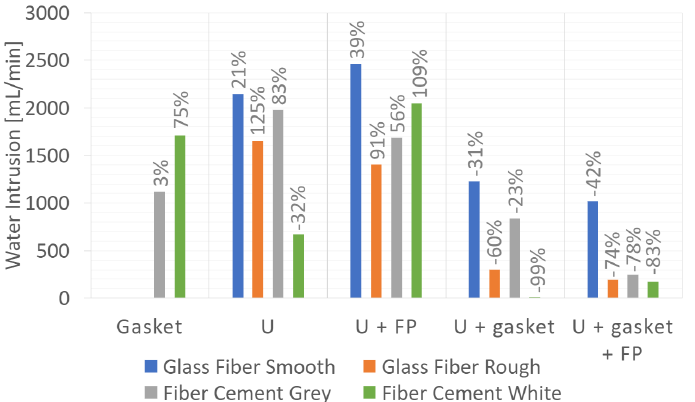
Figure 11. Water intrusion to the wind barrier when profiles behind the joint were used. Gas- ket, U-batten, U-batten + extra fastening points, U-batten + gasket, and U-batten + gasket + extra fastening points. The percentage change from the water intrusion measured with the standard recommendations in Table 3 is